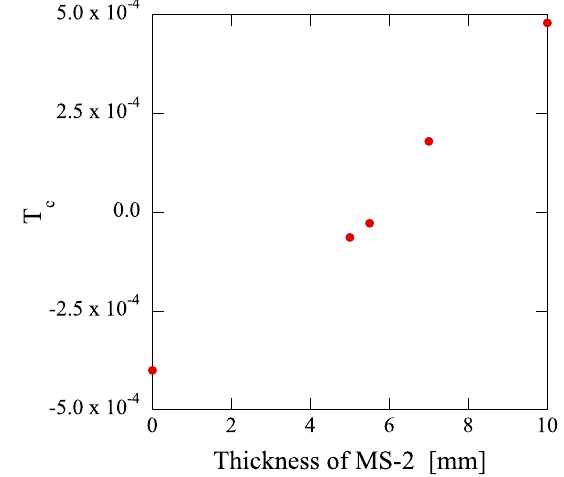
FIG. 11. Temperature coefficient minimization through opti- mization of magnetic-shunt alloy (MS-2) thickness.